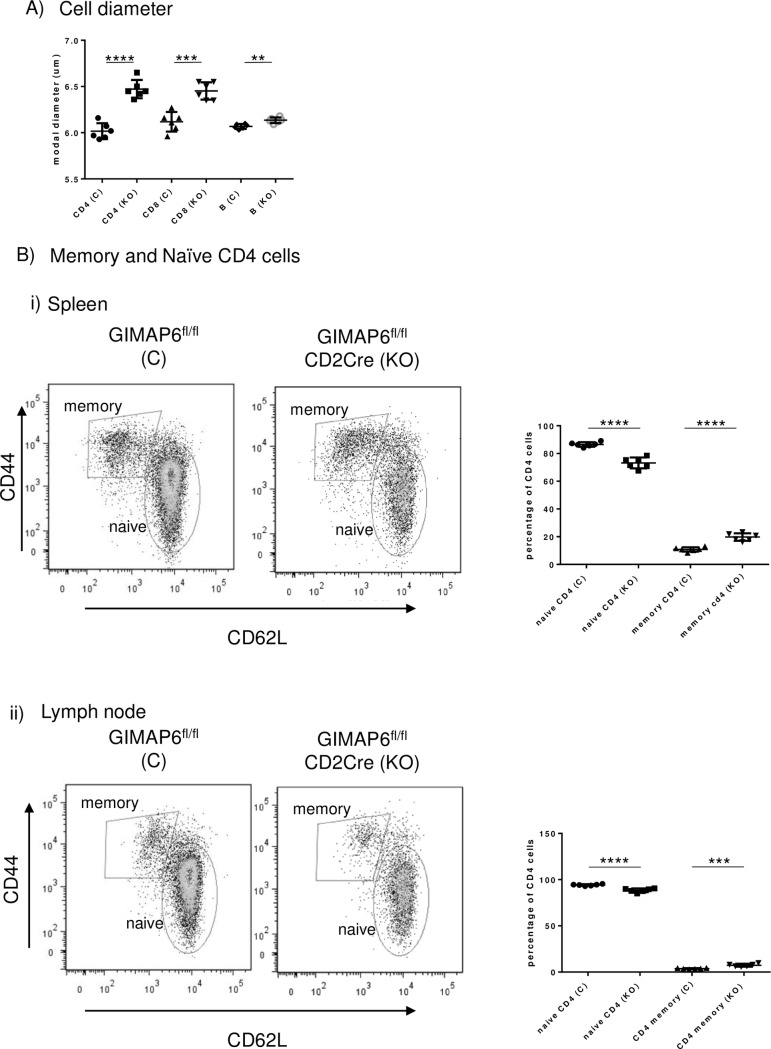
CD4+ cells from GIMAP6fl/flCD2Cre mice show an increased size and a small increase in memory-like characteristics compared with GIMAP6 fl/fl mice.Panel A—The diameters of CD4+, CD8+ and B cell populations isolated from spleens of GIMAP6fl/fl and GIMAP6fl/flCD2Cre animals were measured using an electronic counter (CASY® Cell Counter + Analyser System—Schärfe System GMBH). Panel B–total splenic or lymph node-derived cells were stained for CD4 and then with antibodies to CD62L and CD44. Naïve cells were identified as CD62L+CD44-and memory cells as CD62L-CD44+. Graphs show each population expressed as a percentage of CD4+ cells. n = 6. P values as follows: **P<0.001 **** P<0.0001; n = 6 for each group (unpaired 2-tailed Student’s t test).